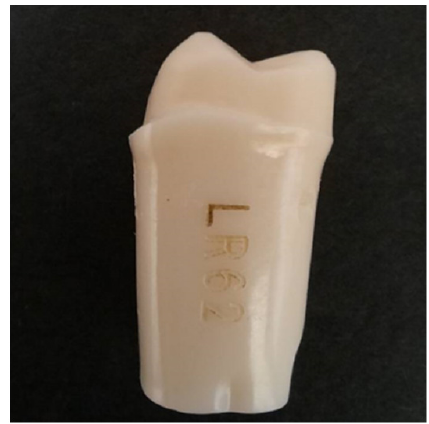
Figure 1. Artificial tooth abutment (LR 62, Nissin Dental Products, Inc., Kyoto, Japan) used in this study.